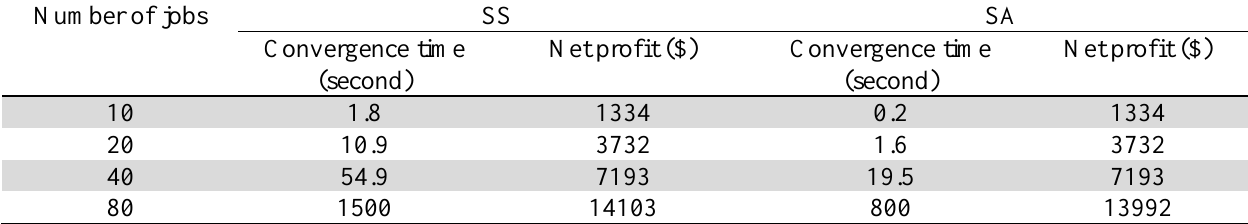
Comparison of Convergence Time and Net Profit of Results Number of jobs SS SA Convergence time Net profit ($) Convergence time Net profit ($) (second) (second) 10 1.8